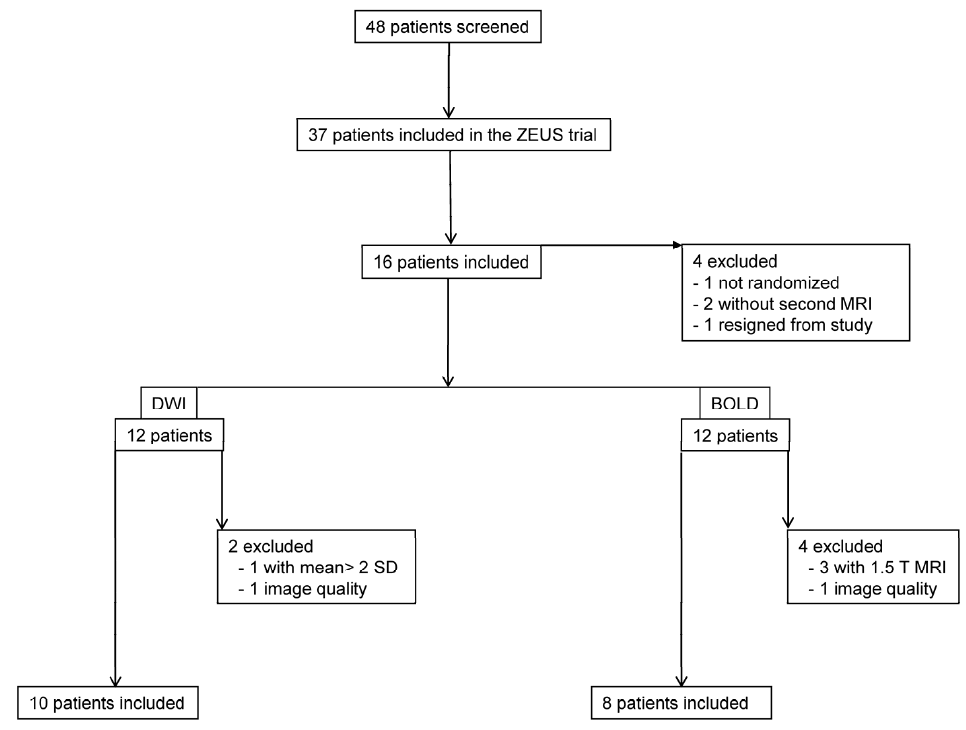
Figure 2. Flow chart. Patient screening and data exclusion.